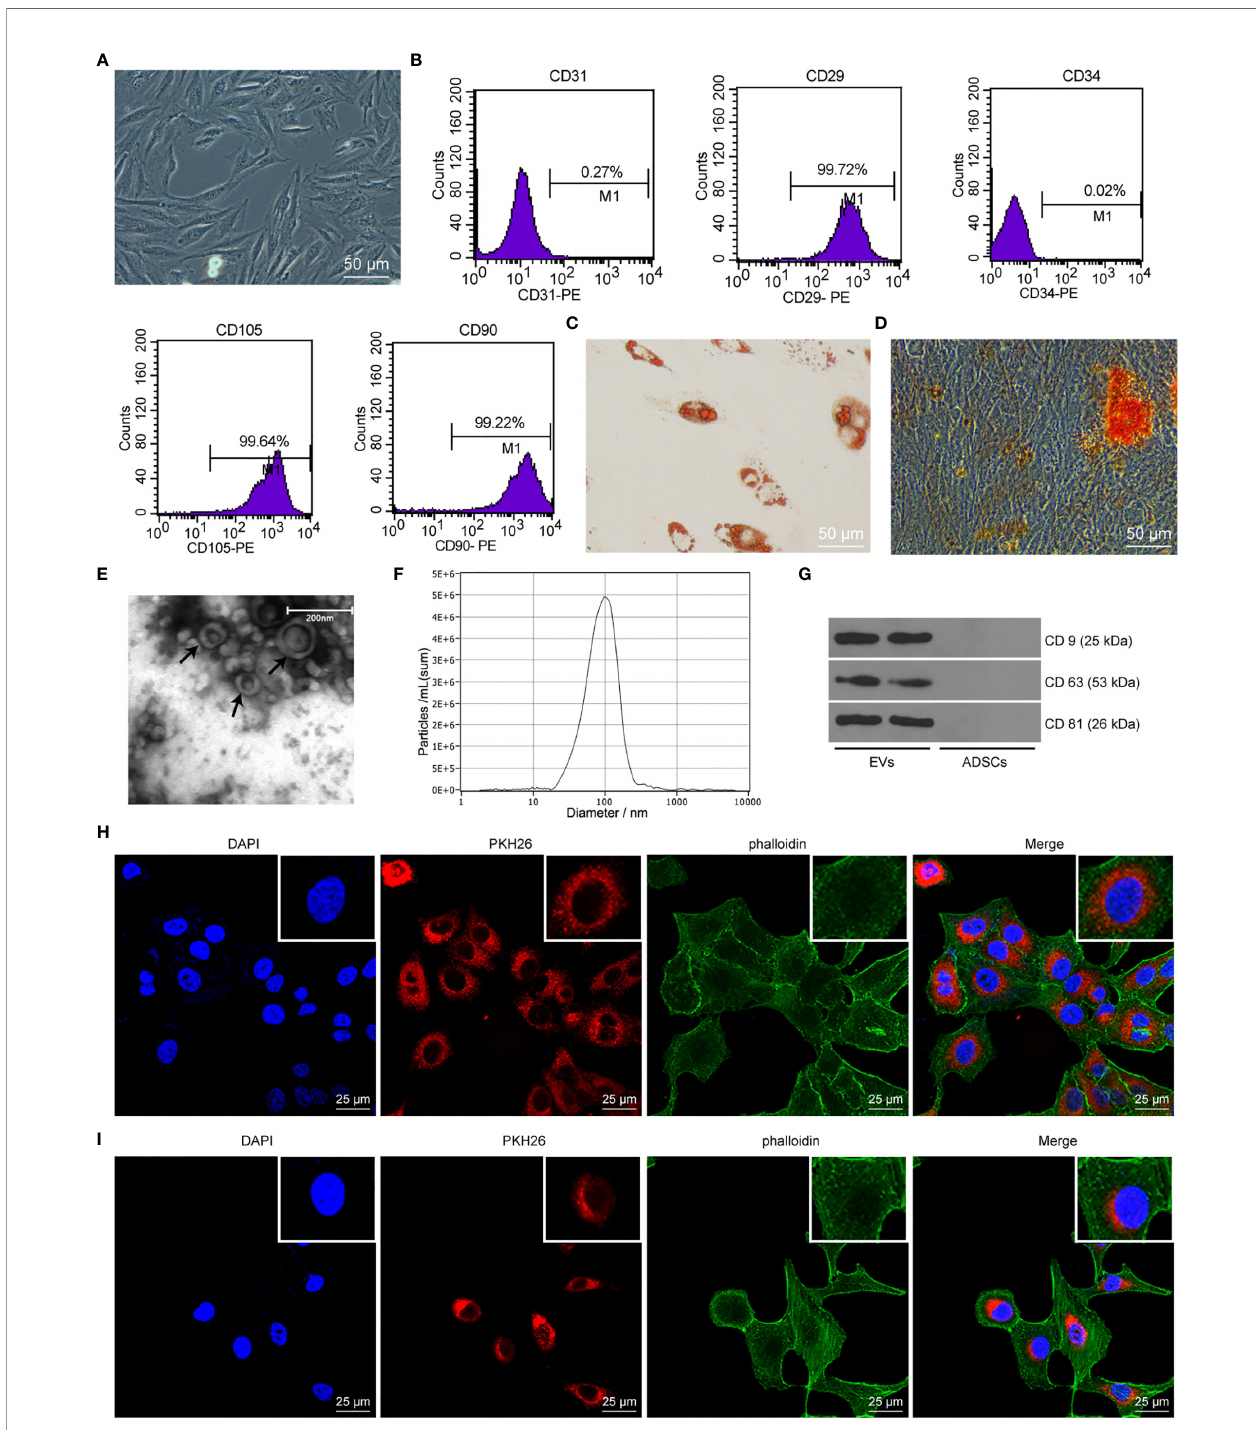
FIGURE 1 | ADSC identi fi cation and characteristics of EVs. (A) Cell morphology of ADSCs at passage 3 was observed with an inverted microscope (× 200). (B) ADSC surface markers (CD31, CD34, CD29, CD90, and CD105) were analyzed by fl ow cytometry. (C) Oil red O staining of ADSCs cultured in adipogenic differentiation medium for 14 days (× 200). (D) Alizarin Red S staining of ADSCs cultured in osteogenic differentiation medium for 21 days (× 200). (E) Morphology of EVs (black arrow) observed by transmission electron microscopy (scale bar, 200 nm). (F) The particle distribution of ADSCs-EVs was measured with NTA (mean 106 ± 4 nm). (G) Western blot assay detection of CD9, CD63, and CD81 expression in ADSCs-EVs. (H) Laser scanning confocal images showed that the fi broblasts internalized PKH26-labeled EVs 24 h later (× 400), the nucleus was blue, the PKH26-EVs was red, and the cytoskeleton phalloidin was green. (I) Laser scanning confocal images showed that the SCs internalized PKH26-labeled EVs 24 h later (× 400), the nucleus was blue, the PKH26-EVs was red, and the cytoskeleton a -actin was